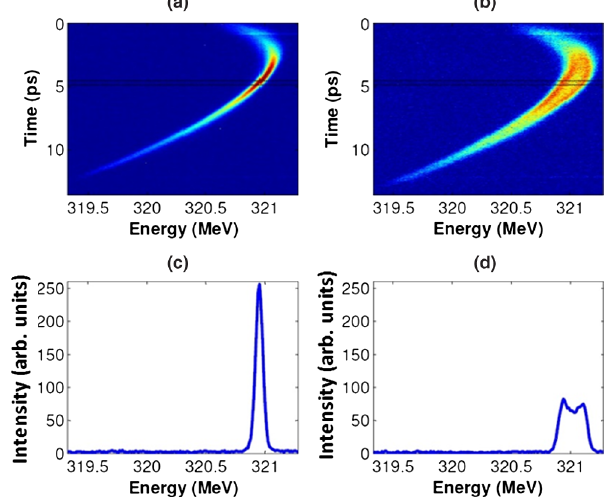
FIG. 4. Electron beam longitudinal phase space reconstructed from measurements at the BC1 spectrometer line. (a) Laser heater off. (b) Laser heater on with 160 μ J energy per pulse. (c) Energy profiles of a central portion of the beam delimited by the black lines in Fig. 4(a) when the heater is off. (d) Energy profiles of a central portion of the beam delimited by the black lines in Fig. 4(b) when the heater is